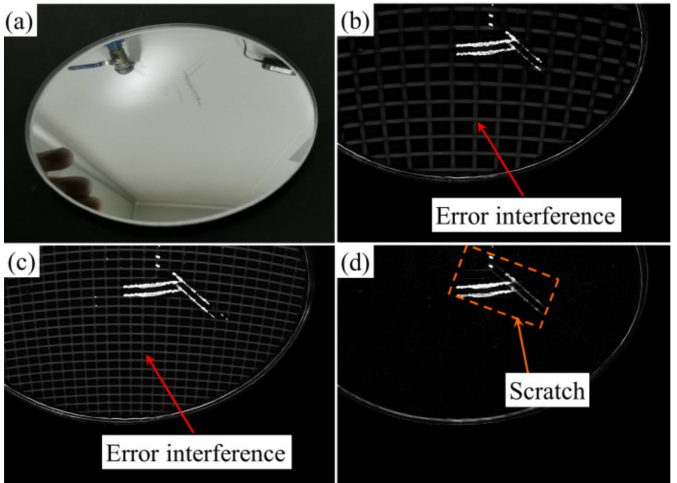
Figure 10. Rearview mirror ( a ) and results of different stripe widths. ( b ) 256 pixels, ( c ) 128 pixels and ( d ) 32